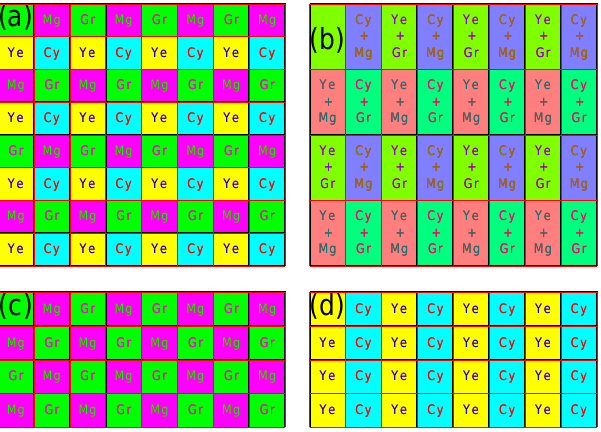
Figure 4. Sony ICX429AKL (a) “raw” full color mosaic, (b) “fast” binned row pairs, (c) even rows, and (d) odd